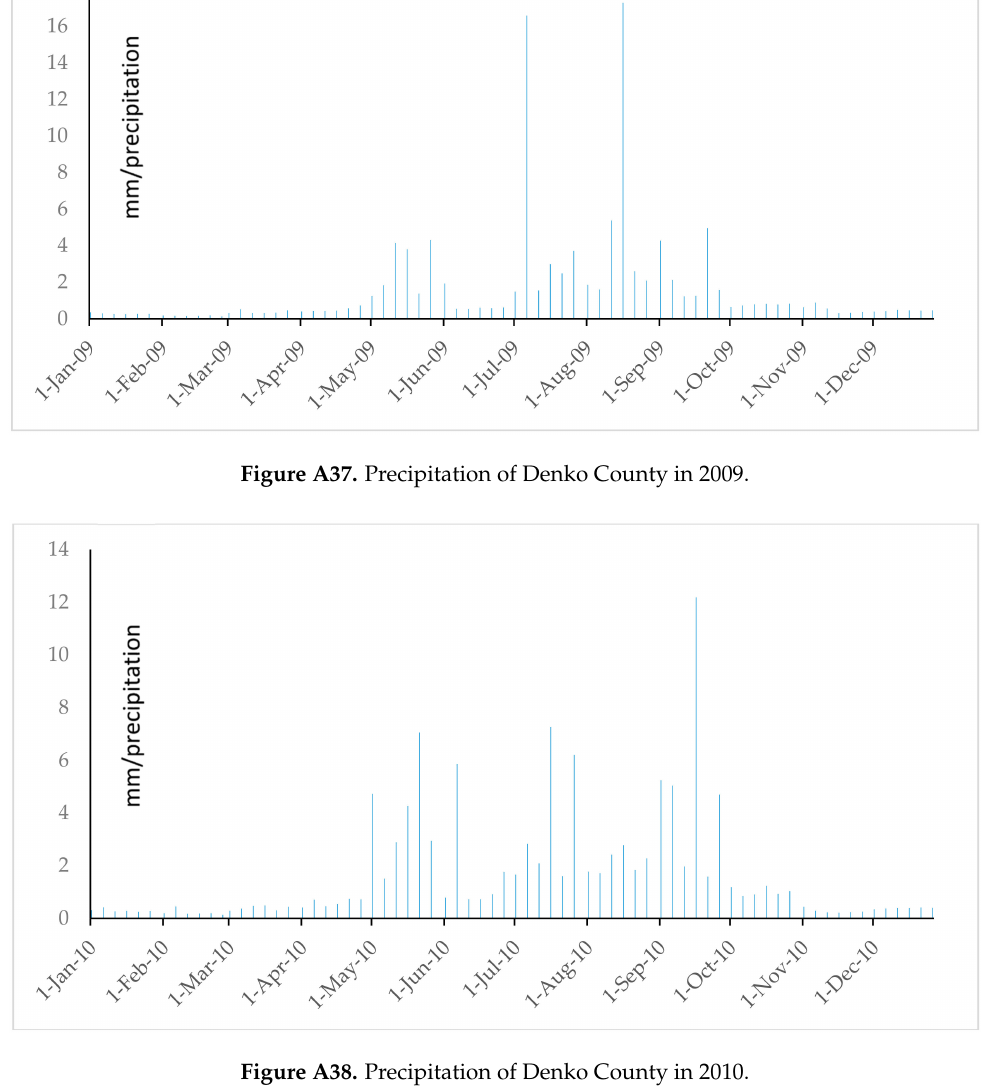
Figure A38. Precipitation of Denko County in 2010.